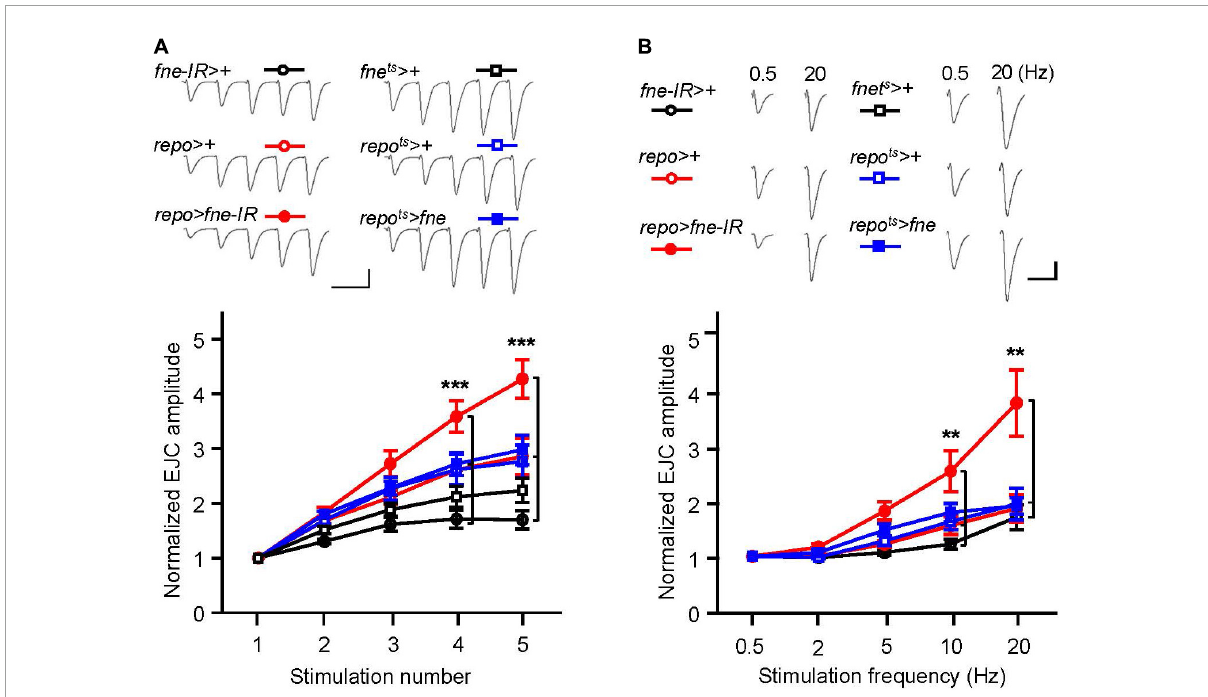
FIGURE8 Change of fne expression in glia altered short-term synaptic facilitation in the larval NMJ. (A) STF during a short train of repetitive stimulation (25 Hz) in the control and in the glia expressing fne and fne-IR . Top, representative traces. Bottom, summary of normalized EJC amplitude. (B) STF were determined at the various stimulation frequency (0.5–20 Hz) in the control and in the glia expressing fne and fne-IR . Top, representative traces of the EJCs for 0.5 and 20 Hz in the indicated genotypes. Bottom, summary of normalized EJC amplitude. The repo ts > fne , repo ts > +, and fne ts > + flies were reared at 18 ◦ C and shifted to 29 ◦ C for 1 day to induce fne expression. Calibration: 10 nA, 50 ms. n = 8 for each group. Error bars represent SEM. ** p < 0.01, *** p <